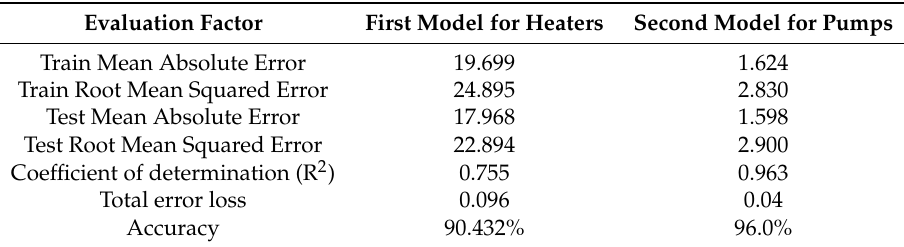
Table 2. Model performance evaluation values.